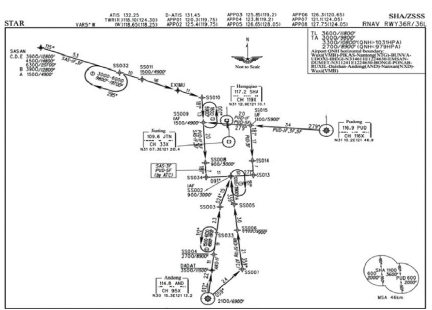
Figure 10: STAR of Shanghai Hongqiao International Airport.